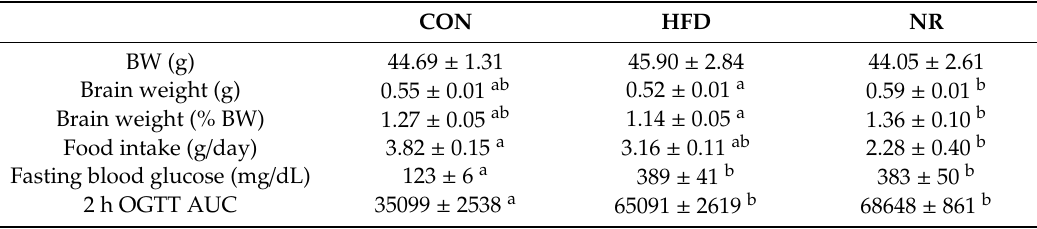
Table 1. The e ff ects of nicotinamide riboside (NR) treatment on body weight (BW), brain weight, food intake, and 2 h oral glucose tolerance test area under the curve (OGTT